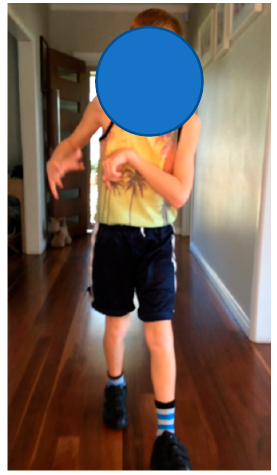
Figure 7. Participant